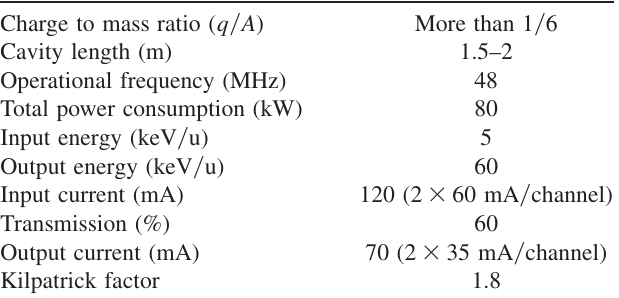
TABLE I. Basic parameter set of the two-beam IH-RFQ linac. Charge to mass ratio ( q=A